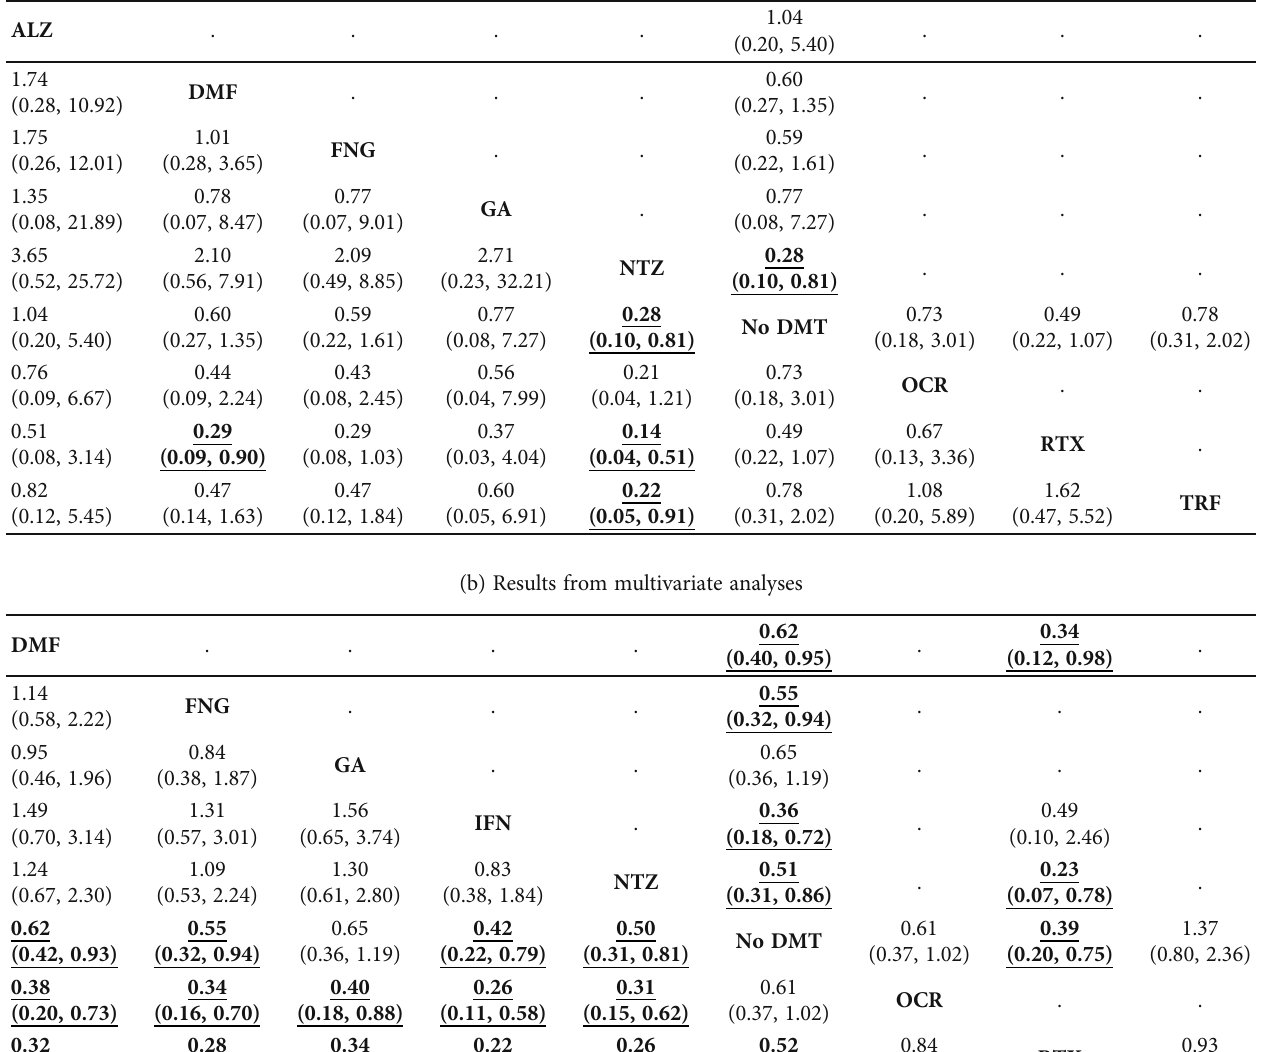
Table 3: League table showing the results of network meta-analysis comparing the e ff ect of DMTs on the severity of COVID-19. (a) Results from univariate analyses ALZ . . .